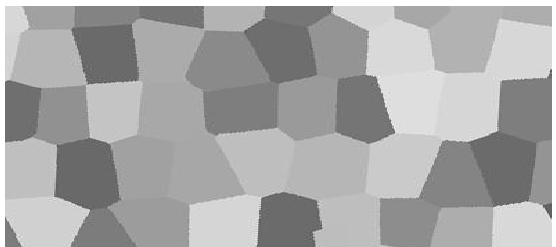
Figure 12 Mask used for inlaying images into the final